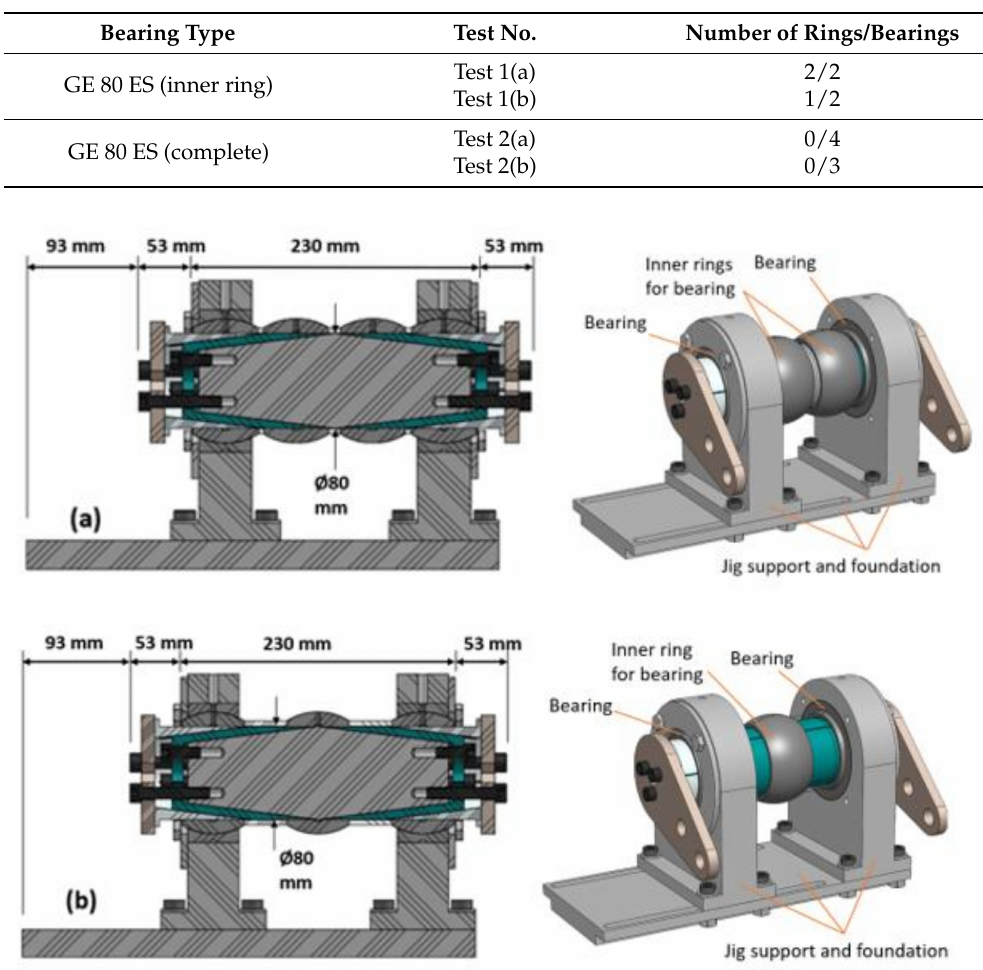
Table 1. Test setup—pin (Ø80 mm) and bearing combinations.